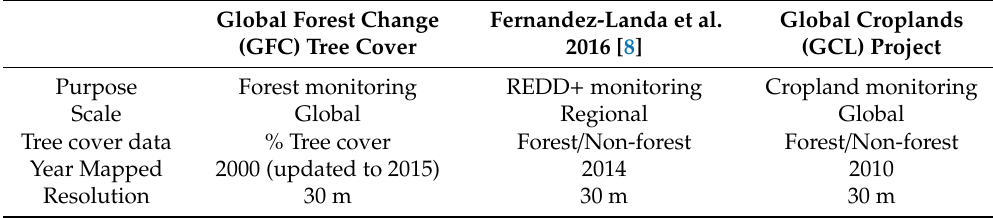
Table 1. Summary of tree cover products compared in this paper. Global Forest